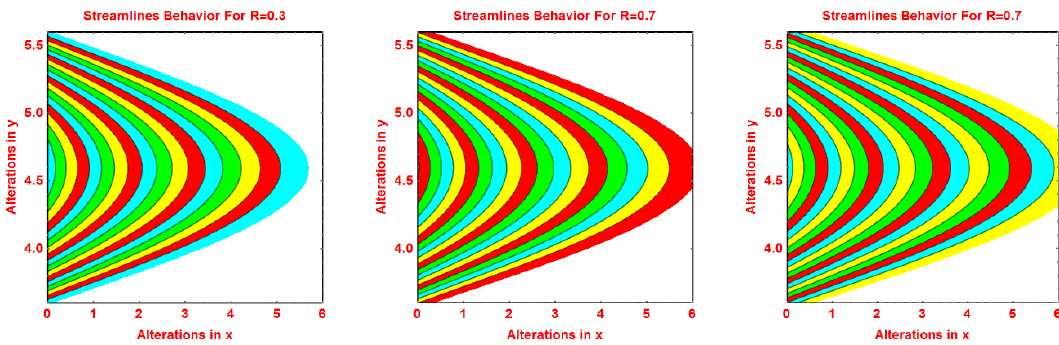
Figure 5. E ff ects of di ff erent values of n on the streamlines pattern. Figure 5. Effects of different values of n on the streamlines pattern. Figure 5. Effects of different values of n on the streamlines pattern. Figure 5. Effects of different values of n on the streamlines pattern.